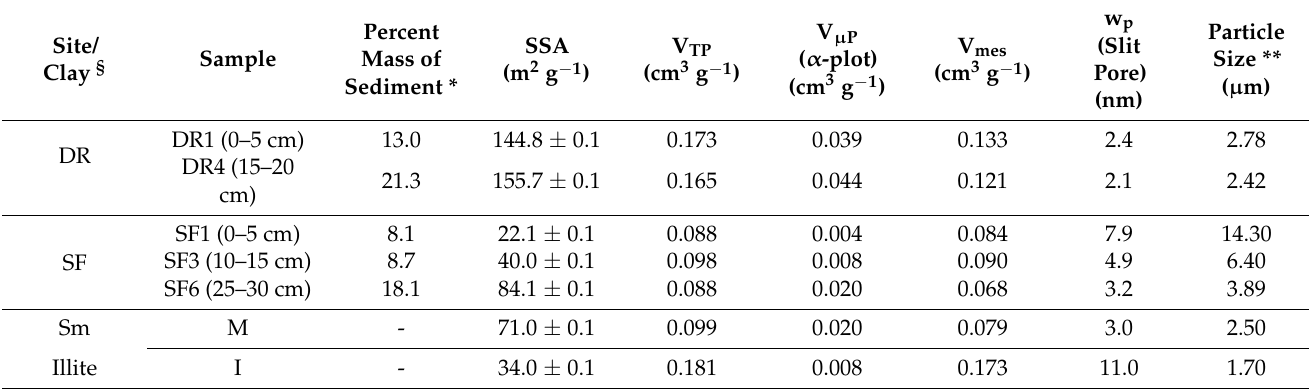
Table 4. Particle size, surface (SSA), textural properties (V TP ; V µ P ; V mes and w p ) and the percent mass of sediment